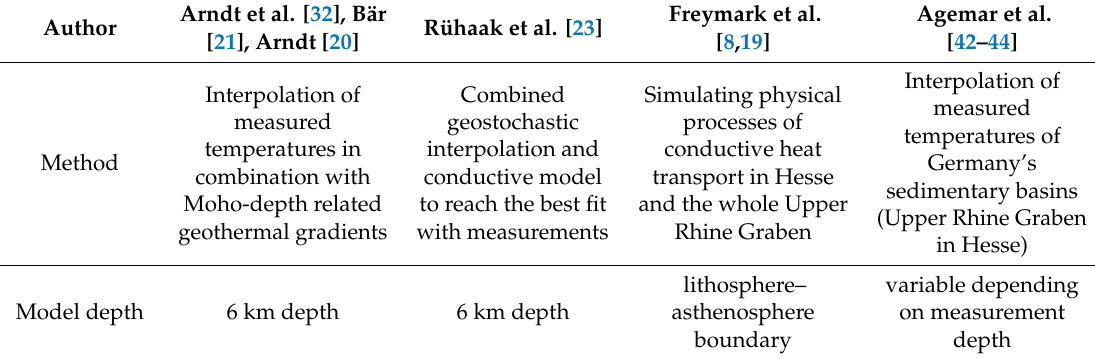
Table 1. Four existing thermal models use di ff erent methods to calculate the thermal field of Hesse.